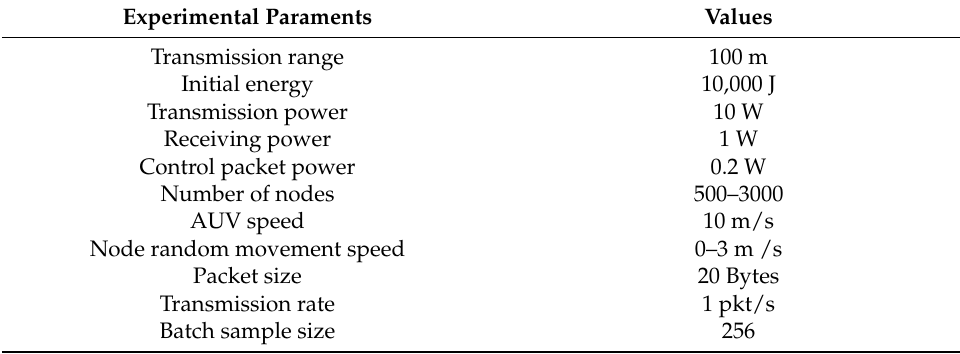
Table 1. Experimental